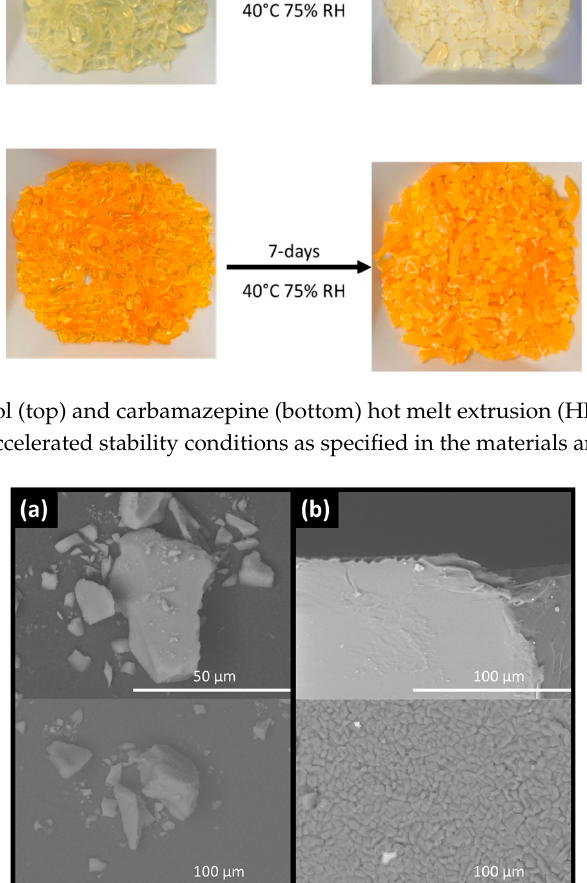
Figure 1. Haloperidol (top) and carbamazepine (bottom) hot melt extrusion (HME) before (left) and